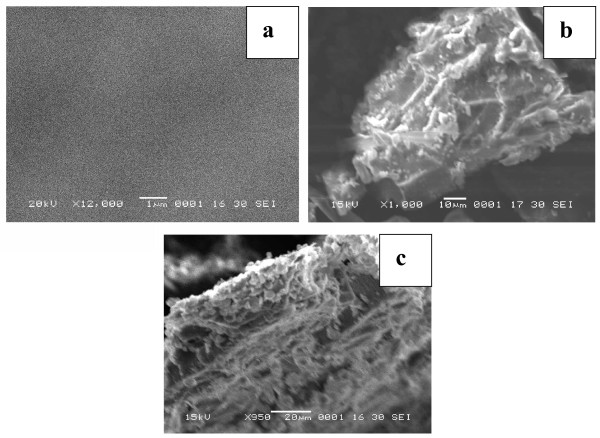
SEM micrographs. (a) PS MA, (b) PSMA + TiO2, and (c) PSMA + γ-APS-TiO2 hybrid nanocomposites.